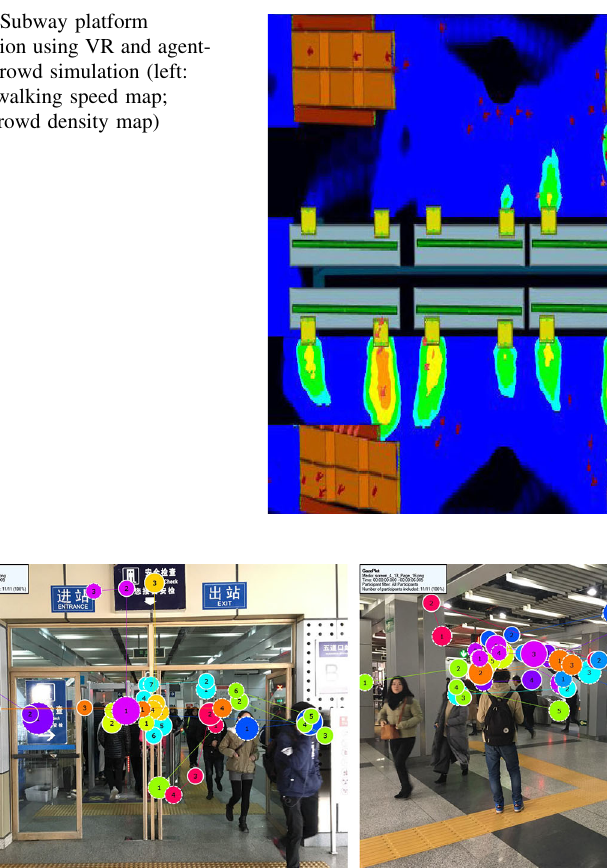
Fig. 3 Subway platform congestion using VR and agent- based crowd simulation (left: crowd walking speed map; right: crowd density map)